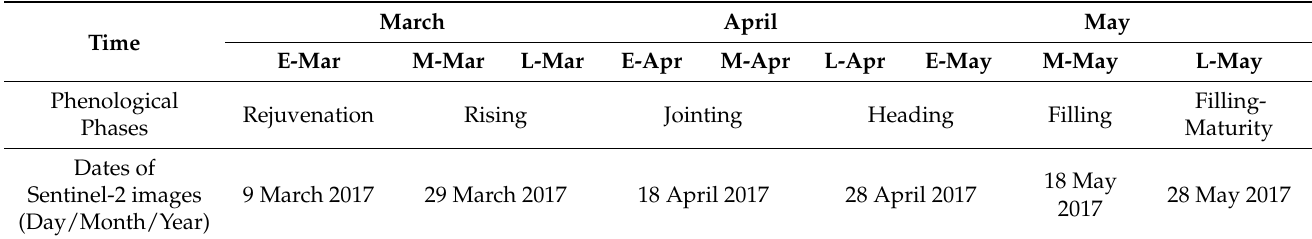
Table 1. Sentinel-2 images covering dates and the phenology of winter wheat.